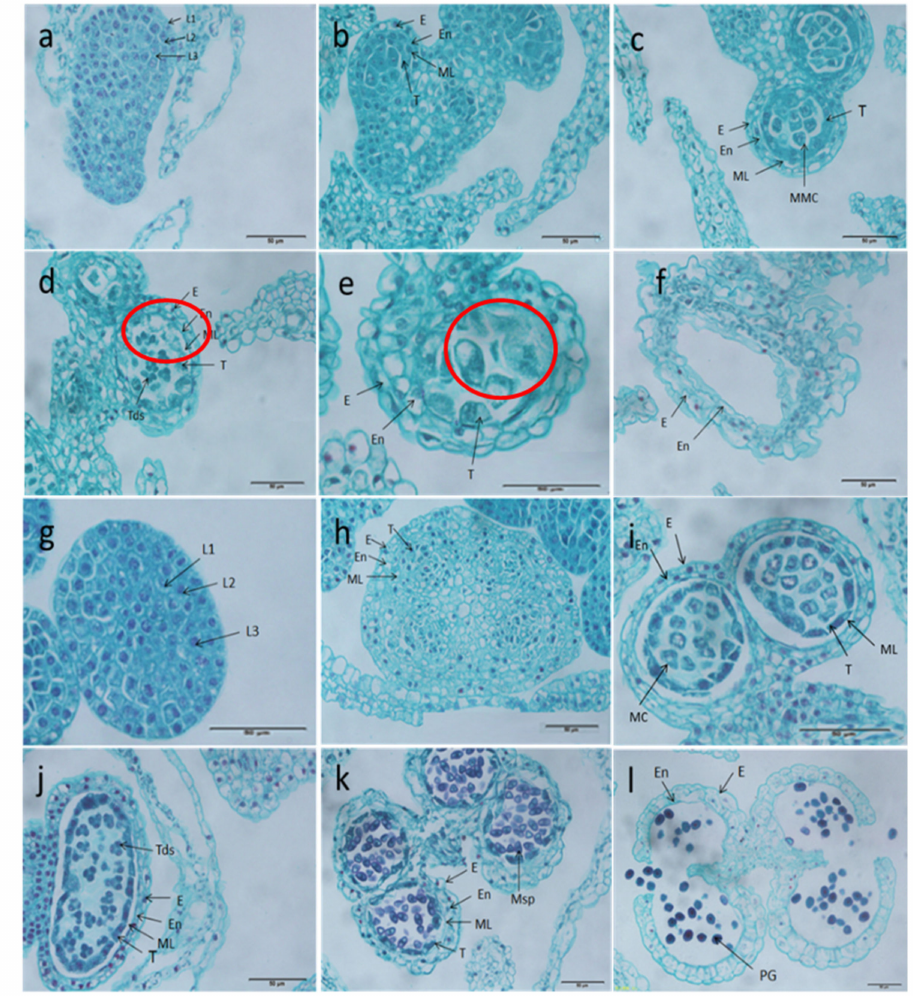
Figure 2. Microspore development of anthers from the celery CMS line W99A and its maintainer line W99B. ( a – f ) Celery CMS line W99A; ( g – l ) maintainer line W99B. ( a , g ) stamen primordium stage; ( b , h ) sporogonia and sporogenetic cell stage; ( c , i ) pollen mother cell stage; ( d , j ) tetrad stage, ( e , k ), uninucleate stage; ( f , l ) pollen mature stage. MMC: microspore mother cell, Msp: microspore, MC: meiotic cells, T: tapetum, Tds: tetrad microspore, PG: pollen grain. E: Extexine, En: endodermis, ML: middle lamella. Scale bars = 50 µ